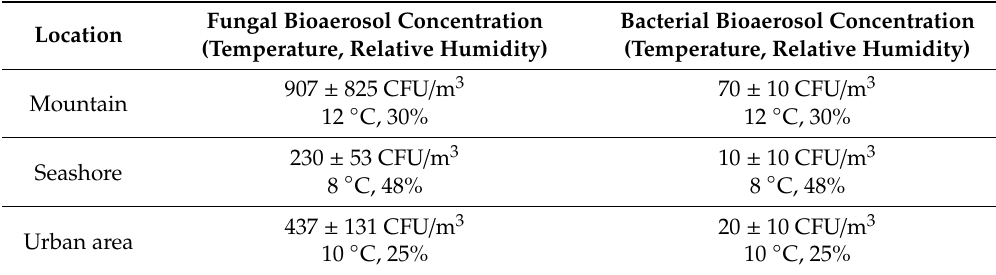
Table 2. Concentrations of culturable bioaerosol particles (February).